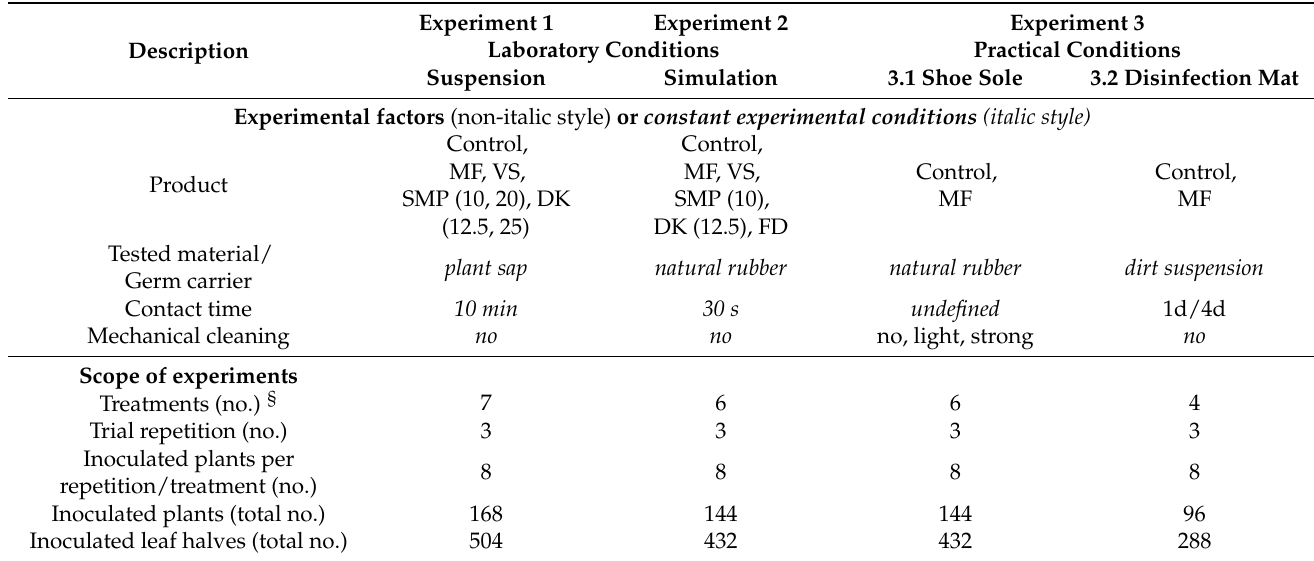
Table 3. Factors and scope of the different